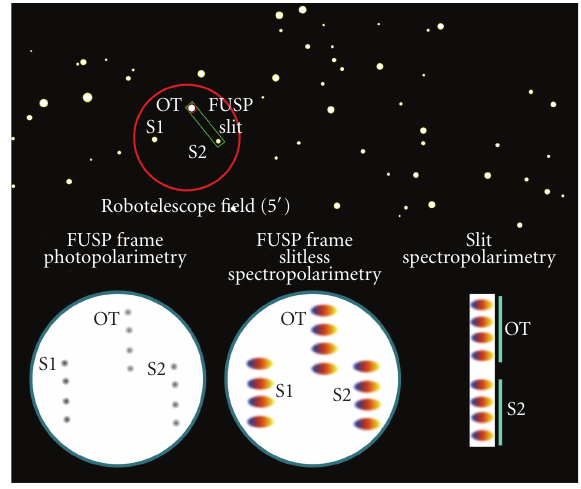
Figure 1: Images of FUSP field of view in di ff erent operational modes.